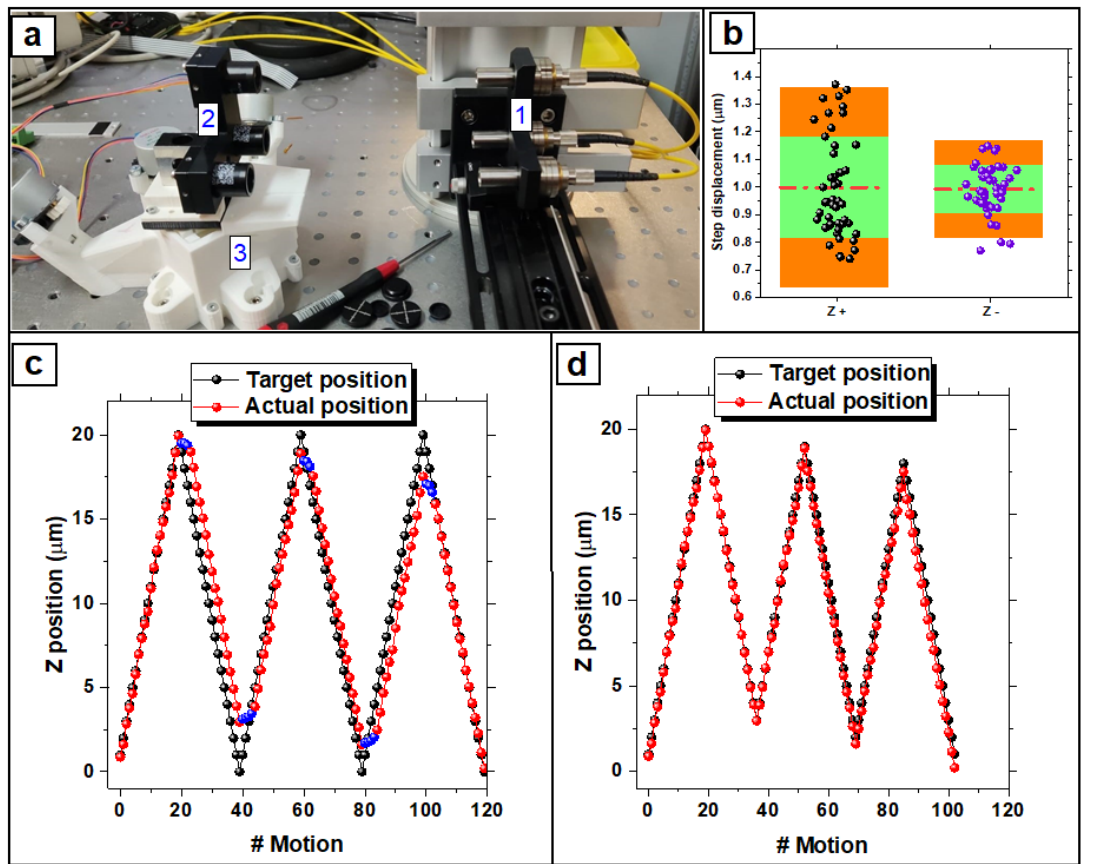
Figure 3. Calibration of the translation stage: step size is evaluated by interferometric measurement. Actuate 20 steps forward and 20 steps backward with nominal displacement of 1 µ m per step along Z direction, repeating this displacement sequence 3 times to quantify the backlash and bidirectional positioning accuracy of Z-axis. ( a ) Calibration set-up: 3 fixed IR lasers (1) and three retroreflectors (2) jointed to the moving platform of the stage (3). The interferometer registers actual displacements of the translation stage for three main directions (X, Y and Z) depending on the geometry (in the picture: Y-axis geometry). ( b ) The actual displacements of every step in Z-direction are evaluated for positive (Z+) and negative (Z − ) displacements. The red line states the mean of single displacement (1 µ m), the green area is limiting steps within one standard deviation and the orange area represents the confidence interval of 95%. ( c ) Three sequences of displacements along the Z-axis: actual positions of retroreflectors jointed to the translation stage (red points) are strongly affected by backlash (blue points): the bidirectional systematic error is E = 3.2 µ m. Backlash correction is actuated by overshooting steps to reduce deviation from target positions (black points). ( d ) Conduct 3 sequences of displacements along the Z-axis with backlash correction: the systematic bidirectional error is E = 0.5 µ m.